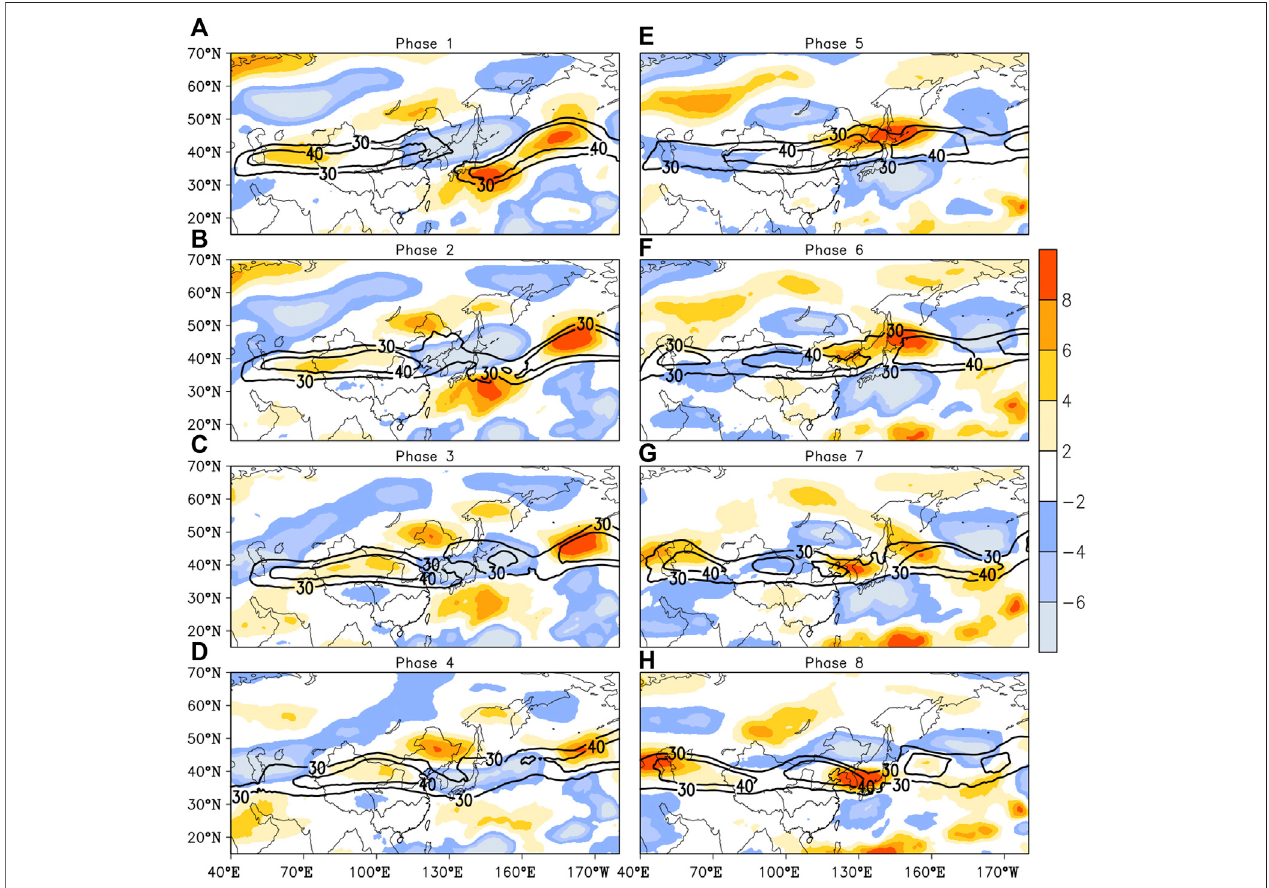
FIGURE10| Composite8 – 16 daysLanczos fi ltered200-hPazonalwinds(shaded,unit:m s -1 )correspondingtoeightevolutionphasesofQWBOrainfallinsecond and third rainfall processes. Red lines denote 30 and 40 m s -1 contours at un fi ltered 200-hPa zonal winds. A – H correspond to the eight phases of the composite evolution of QWBO component of the the second to third rainfall processes.